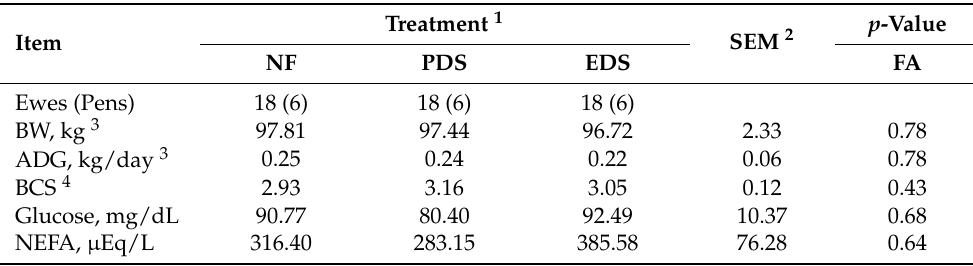
Table 4. Effect of a fatty acid enriched diet during the last 50 days of gestation on ewes’ body weight (BW), body condition score (BCS), average daily gain (ADG), and plasma